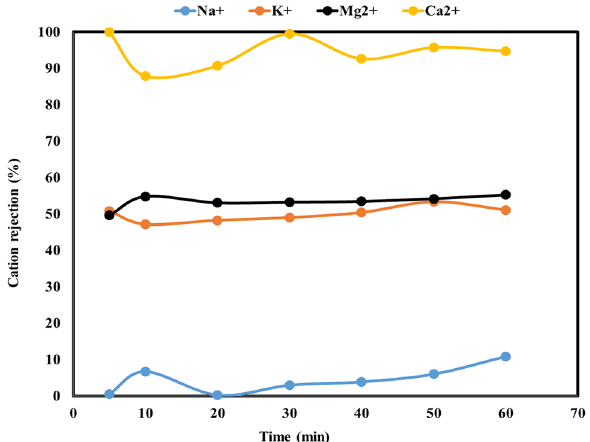
Table 2 Elemental composition of the clay samples as measured